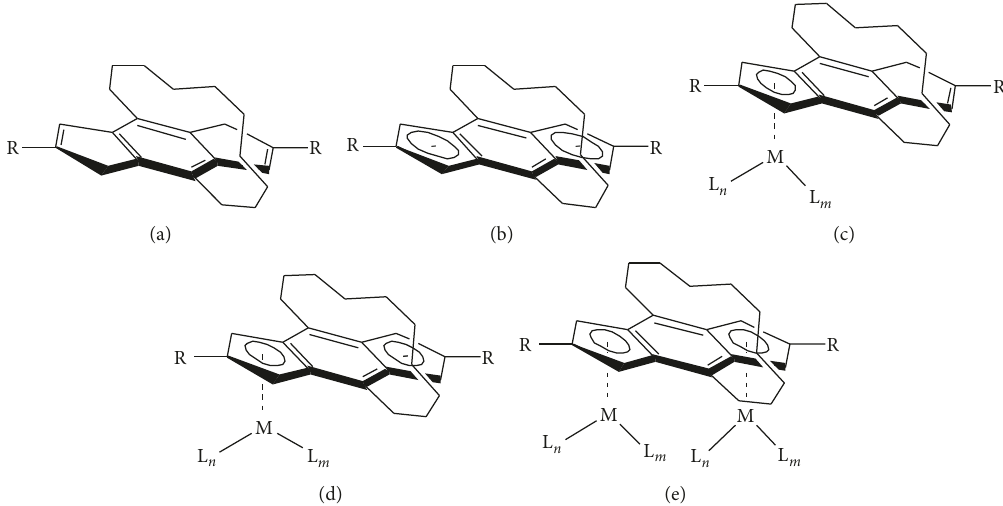
Figure 1: Structures of the studied systems. (a) Neutral ligand, (b) dianion ligand, and (c) neutral monometallic, (d) monoanion monometallic, and (e) bimetallic systems. R = H, CH 3 , and CH 2 CH 3 ; M = Ir, Rh, and Re; L